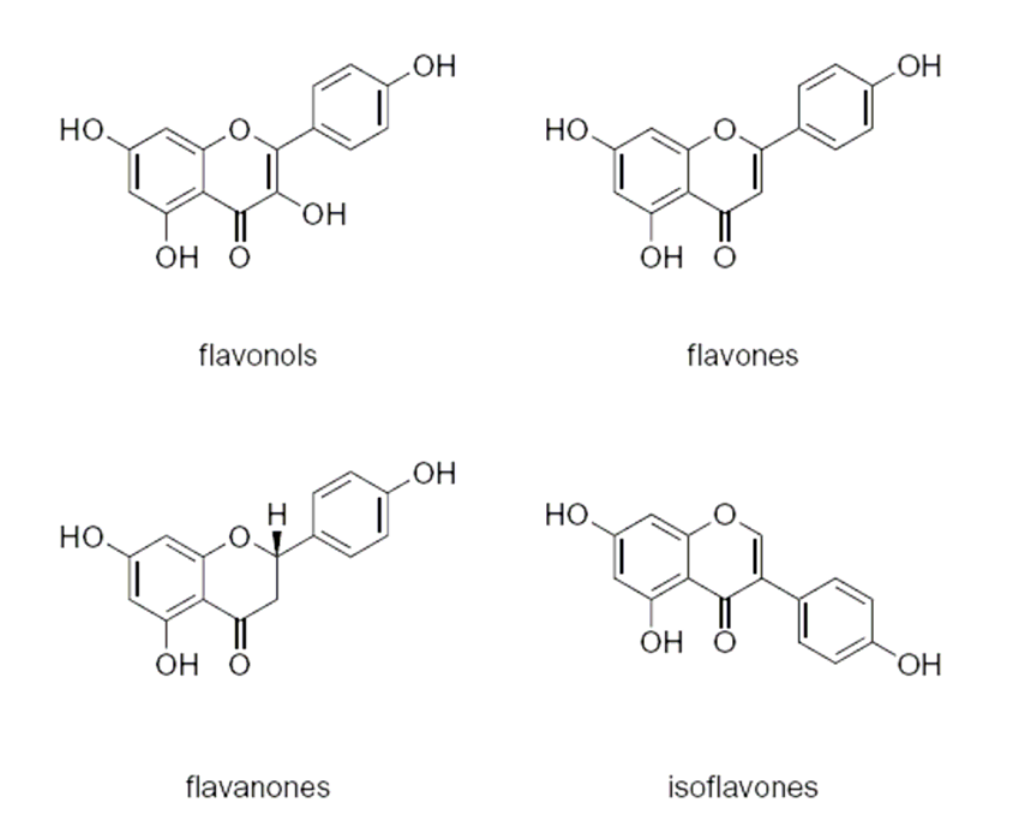
Figure 1. Chemical structures of the different groups of flavonoid